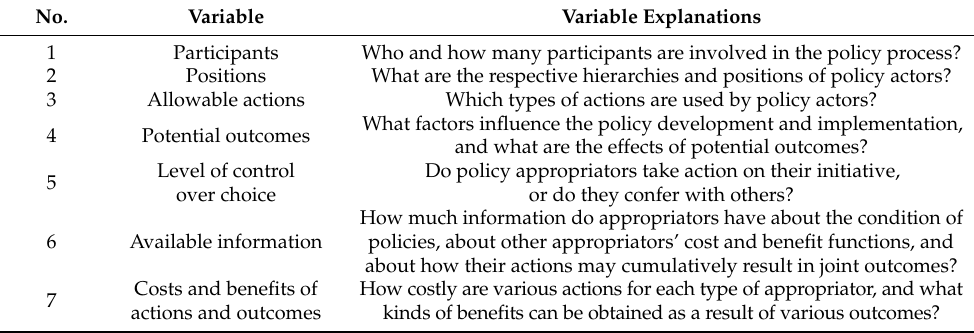
Table 2. Environmental variables of the action